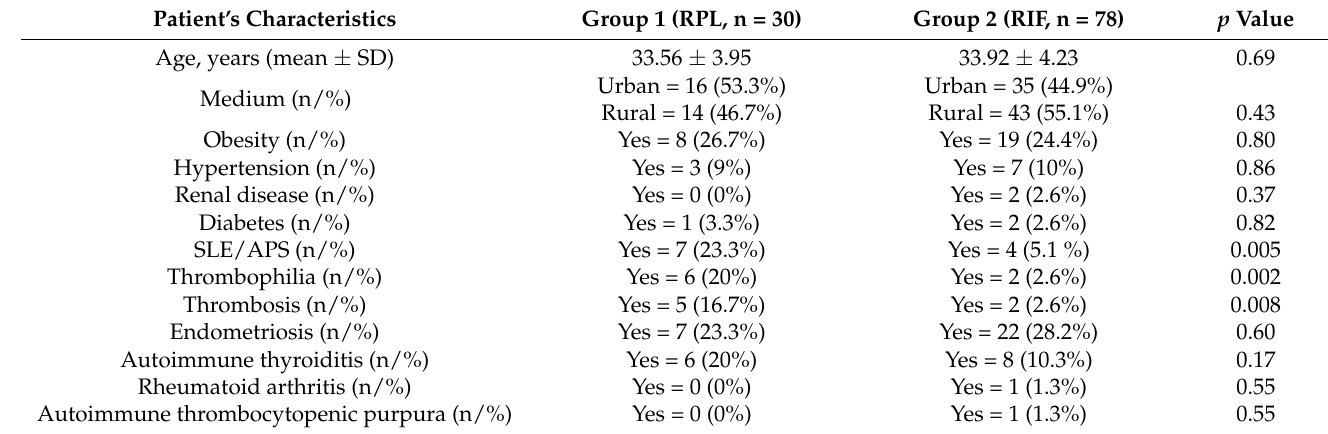
Table 1. Clinical characteristics of the patients included in the main groups.